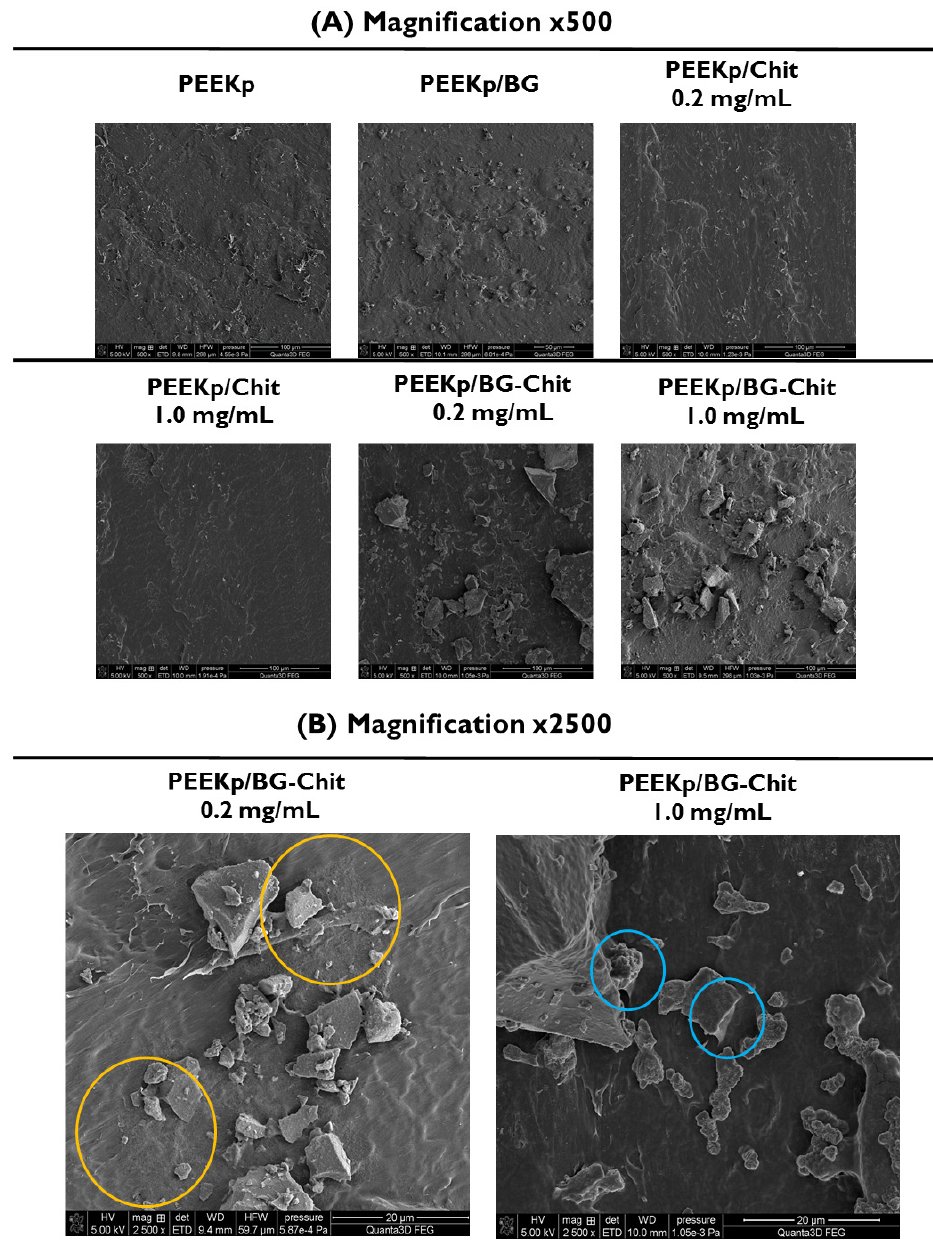
Figure 2. ( A ). SEM images of the modified PEEK surfaces with ×500 magnitude. The yellow circles show the structure of chitosan films. ( B ). SEM images of PEEKp/BG-Chit 0.2 and 1.0 mg/mL with ×2500 magnitude for better visualization of the BG − Chit mixed coatings. The blue circles denote bioglass fusion sites with the solid support.